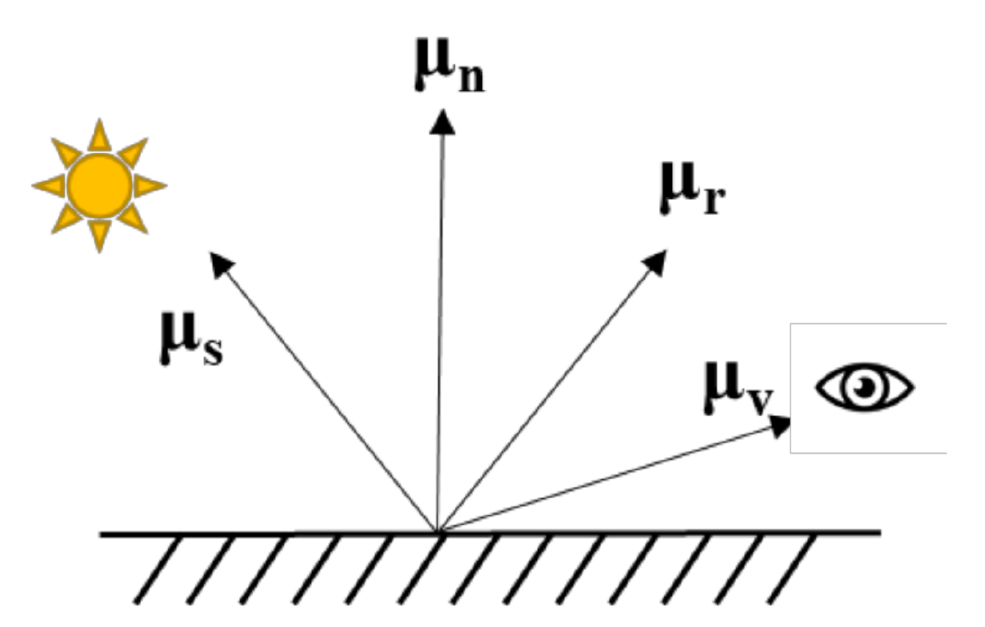
Figure 15. Diagram of Phong model, µ s , µ n , µ r , and µ v are the light source, surface normal, reflected, and viewing vectors,